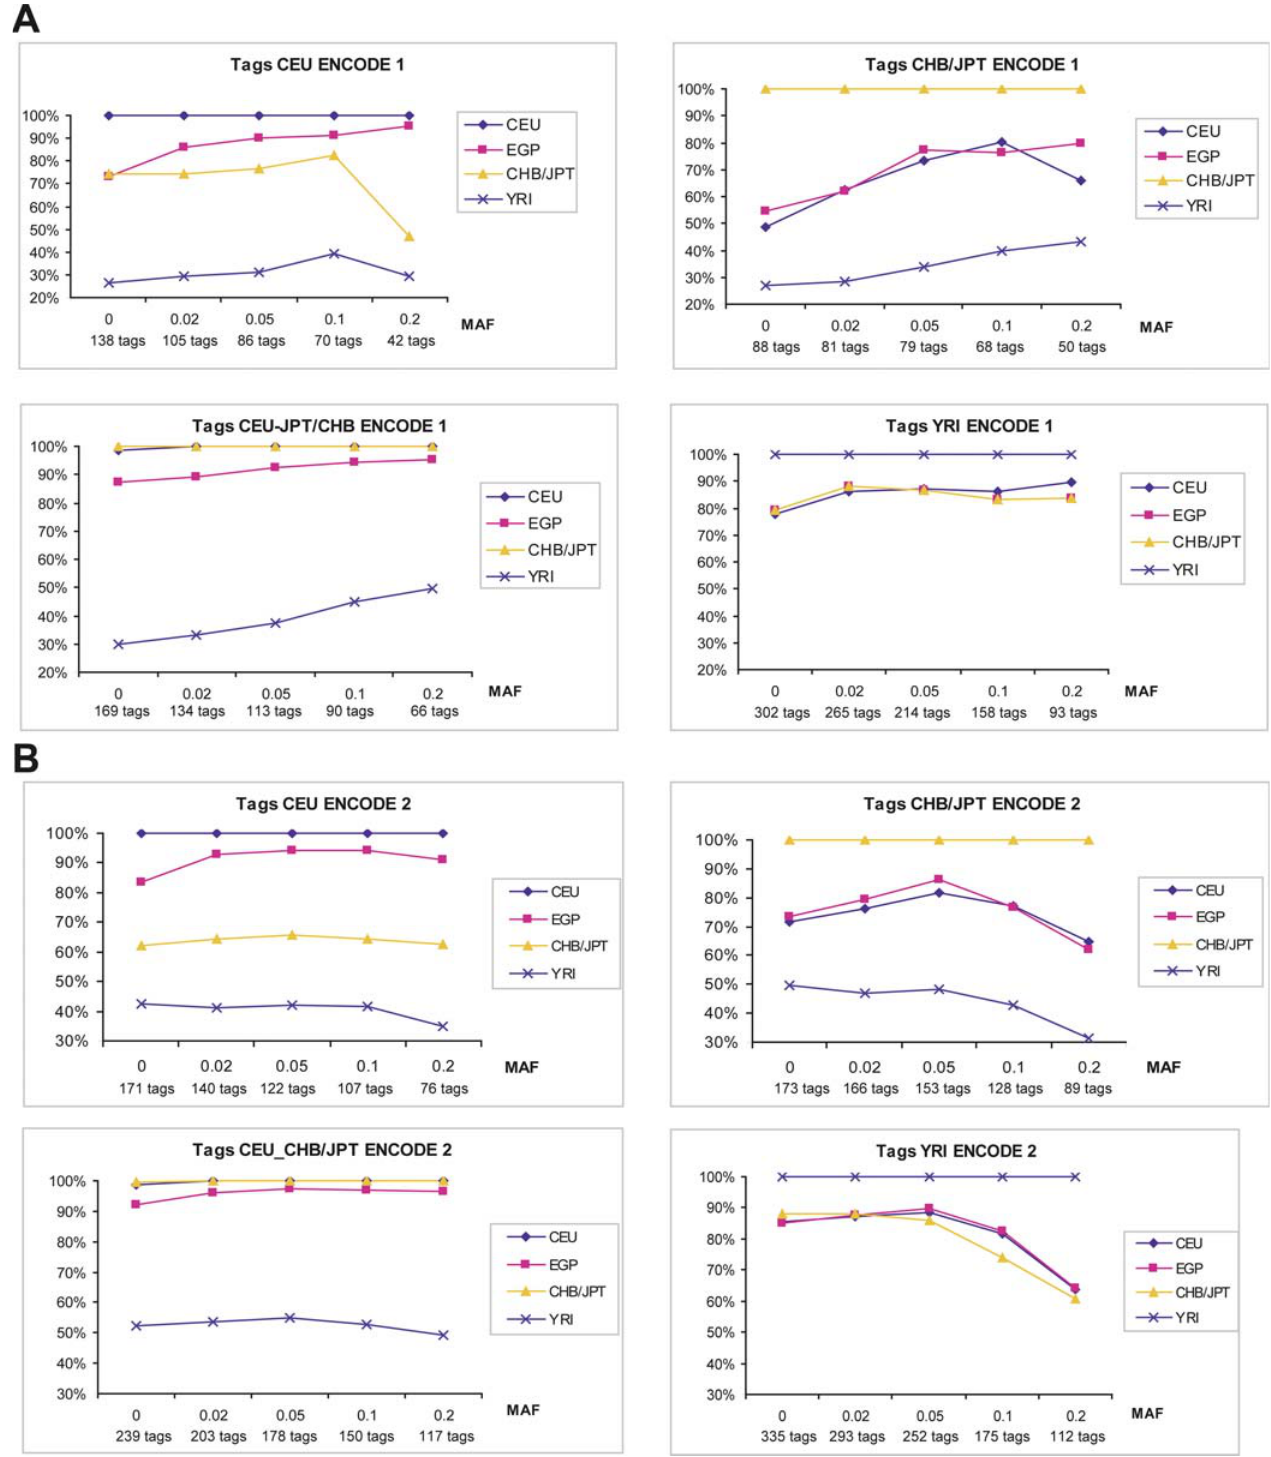
Figure 5. Performance of Tags Selected from HapMap Samples Tags were selected from one or two HapMap samples, and the performance plotted was measured in the indicated population (A) in the ENCODE 1 region and (B) in the ENCODE 2 region. Only polymorphic SNPs with at least the specified MAF were used to select either the tags or to calculate the performance. The number of tags used for each MAF studied is indicated at the bottom of each graph. DOI: 10.1371/journal.pgen.0020027.g005